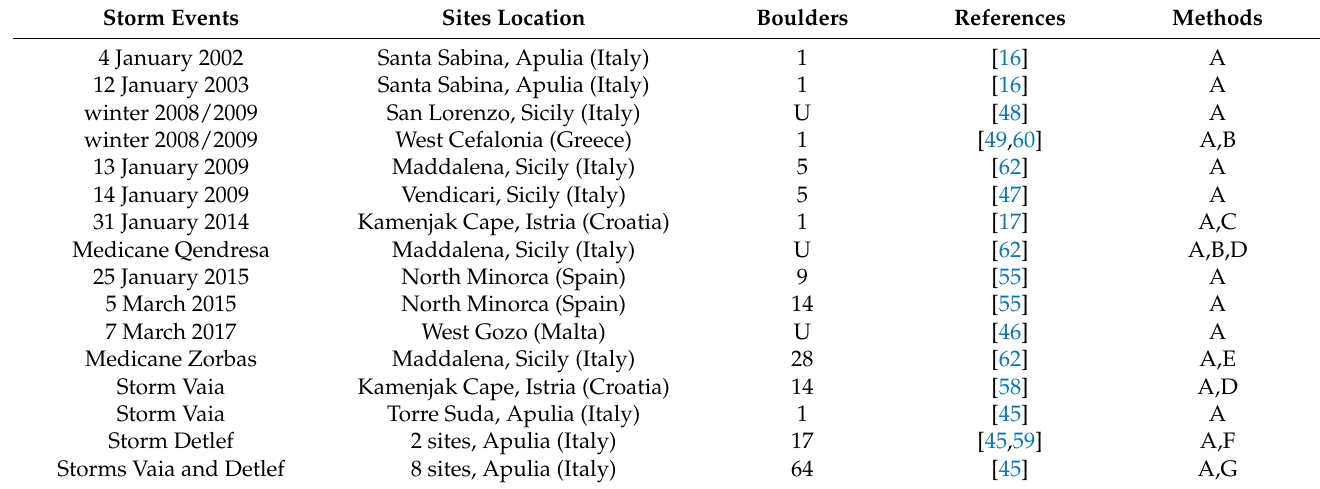
Table 3. Boulders produced/activated during the selected meteorological events. U =